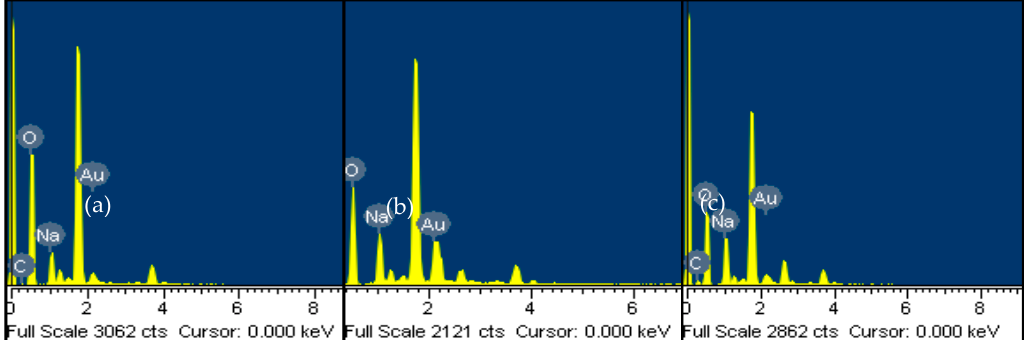
Figure 4. Energy dispersive X-ray spectrometry (EDS) spectra of gold colloidal suspensions at pH 4.7 ( a ), 5.0 ( b ), and 5.3 ( c ). Highest peaks (not labeled on the spectra) correspond to the silicon from the glass supports.